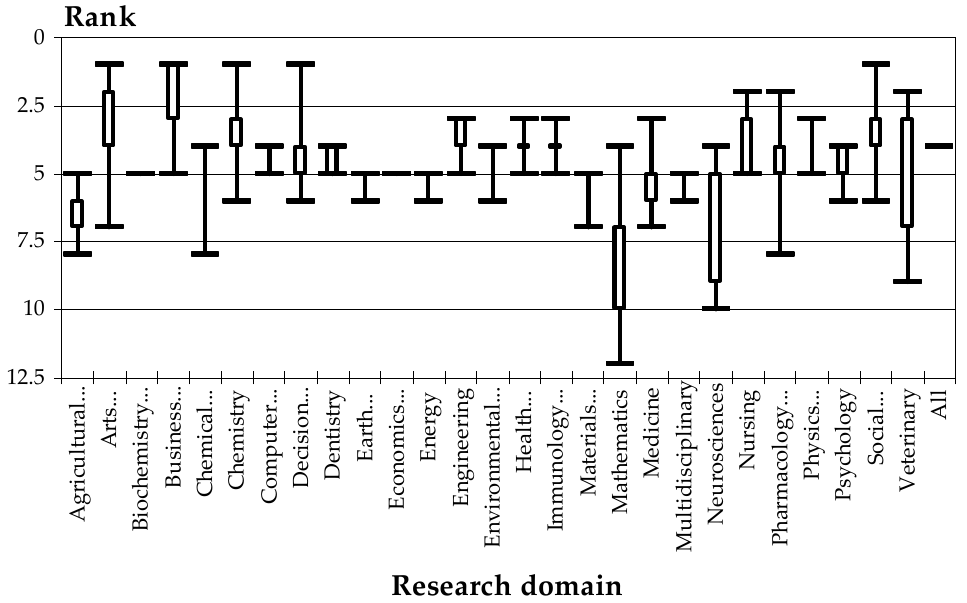
Figure 12. The number of documents published in different fields in Romania during 2010–2018. The figure displays boxplots of the ranks of fields computed for each year separately. Results indicate that the values are in the top part of the ranking for most fields.